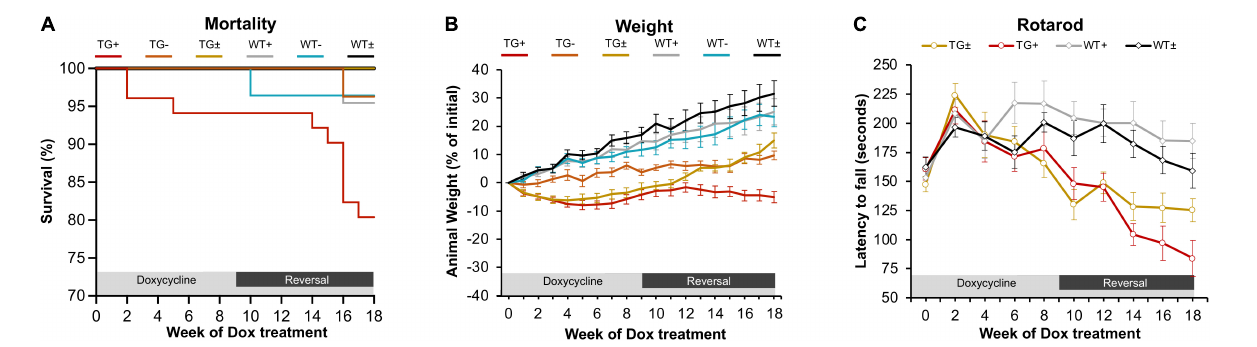
FIGURE 1 | FRDAkd mice induced by doxycycline-compounded feed display FRDA-like phenotype (A) Survival rate of the FRDAkd mice after dox-feed induction. (TG + , n = 51; TG-, n = 27; TG ± , n = 13; WT + , n = 44; WT-, n = 28; WT ± , n = 14). (B) Animal weight throughout dox treatment and reversal in all groups ( n = 21 TG + , n = 6 TG-, n = 13 TG ± , n = 17 WT + , n = 14 WT-, n = 14 WT ± ). (C) Rotarod analysis throughout dox treatment and reversal in all groups TG ± , n = 8; TG + , n = 6; WT ± , n = 8; WT + , n = 8. Stats for panels C and D: Two-way repeated-measures ANOVA with Tukey’s post hoc ( p values in Table 2 ). (TG + = transgenic with dox treatment for 18 weeks, TG- = transgenic no dox treatment, TG ± = transgenic with dox treatment for 9 weeks and reversal for subsequent 9 weeks, WT + = wild-type with dox treatment for 9 weeks, WT- = wild-type no dox treatment, WT ± = wild-type with dox treatment for 9 weeks and reversal for subsequent 9 weeks.) At week 0, all mice were between 2 and 5 months of